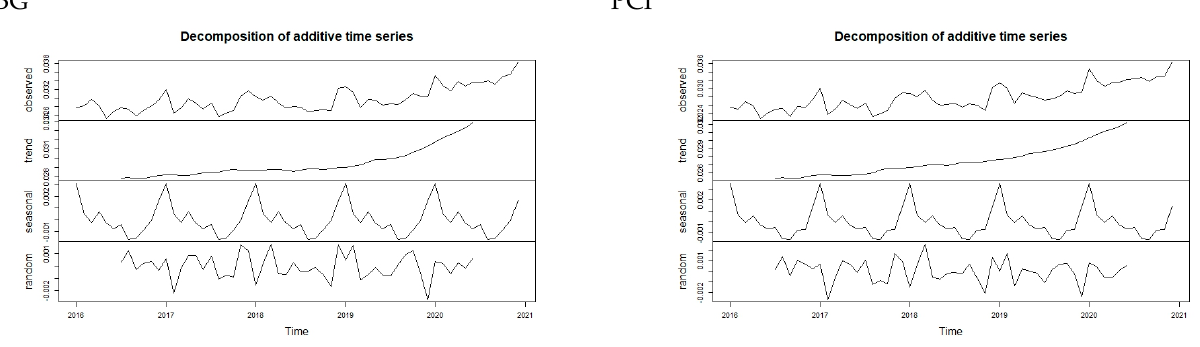
Figure 3. Decomposition of additive time series. General models of segmented regression equations: